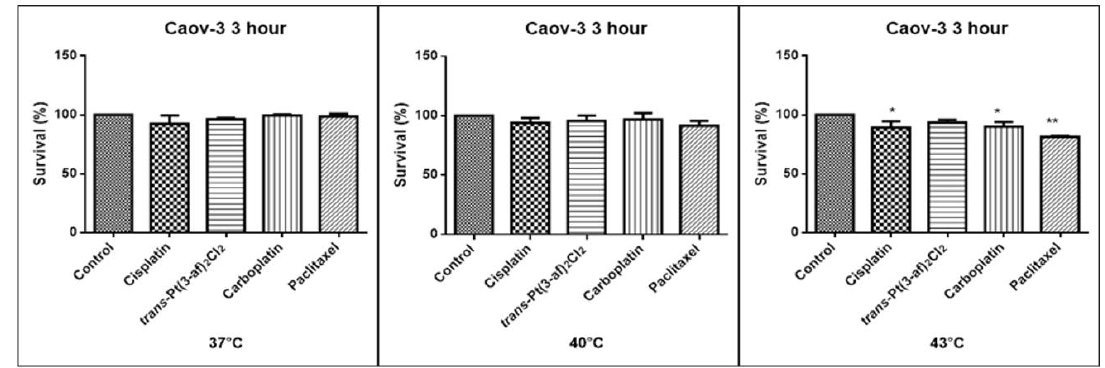
Figure 5. The effect of the elevated temperature of the tested formulations on the Caov-3 ovarian cancer line cells was determined by a MTT test. Data on the figures are presented as mean values obtained from three independent experiments * ( p < 0.05), ** ( p < 0.01).